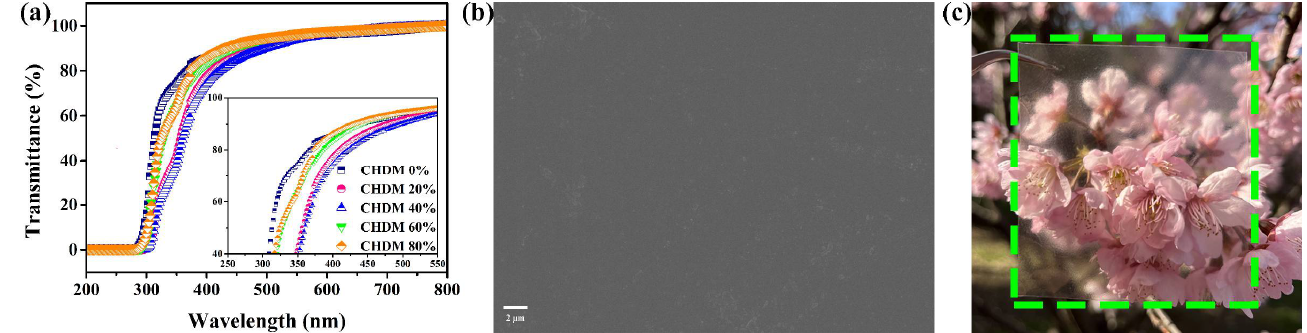
Figure 9. The light transmittance ( a ), SEM image ( b ), and photograph ( c ) of cross-linked